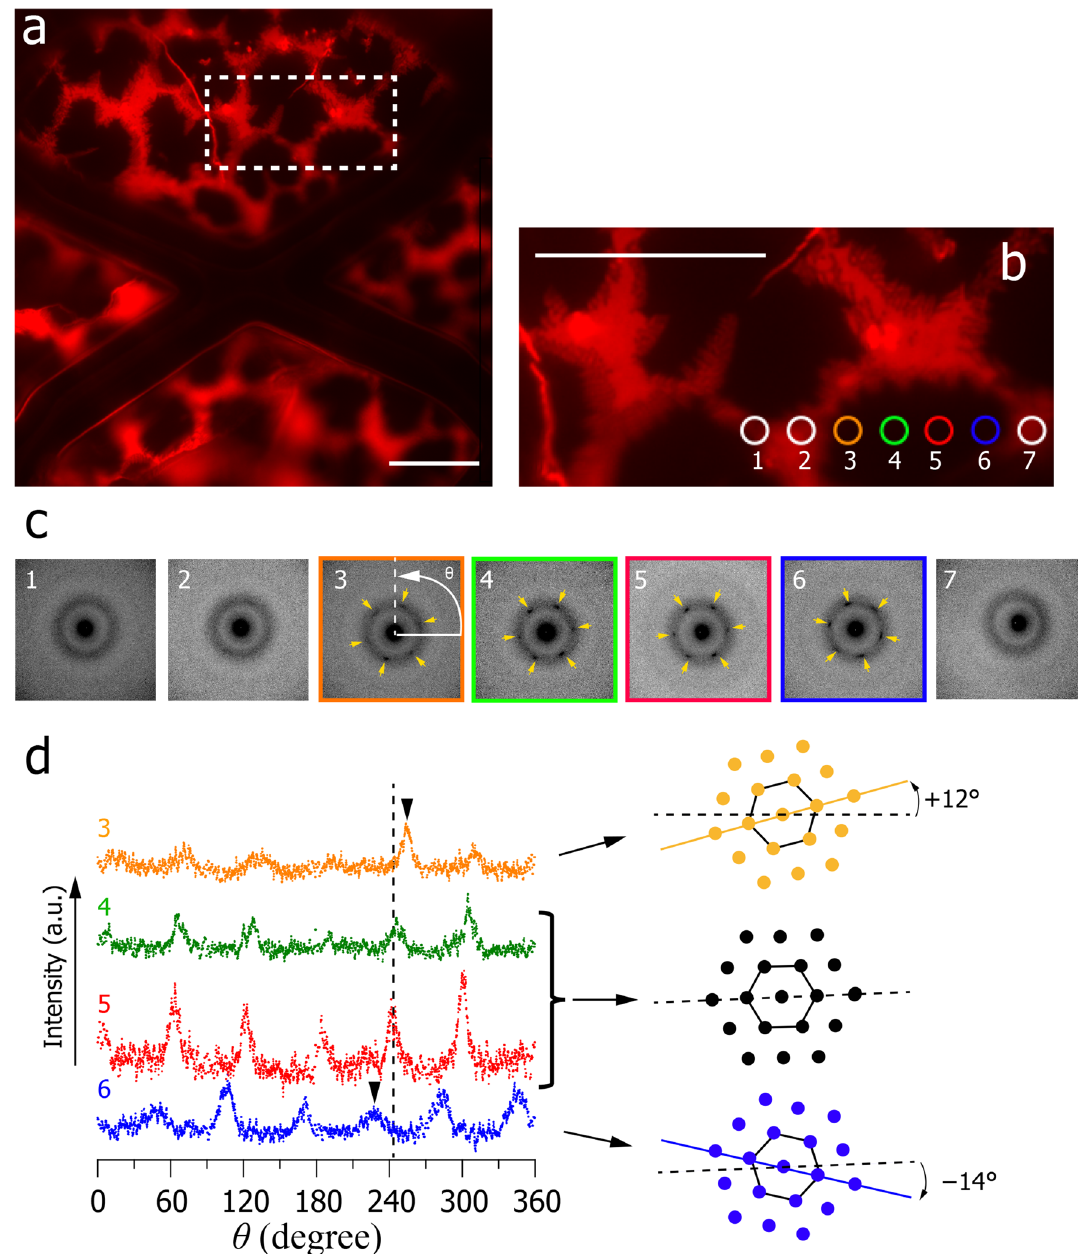
Figure 6. Local structure inside an ordered domain. ( a ) A fluorescent micrograph of the DSPC/DOPC ( x DSPC = 0.3) monolayer formed on a collodion-coated TEM grid. The darker and brighter regions correspond to the DSPC-rich ordered and DOPC-rich disordered domains, respectively. ( b ) Magnification of the area, which is indicated by the dashed square in ( a ). Bars indicate 30 μm. ( c ) The ED patterns obtained at regions 1–7, as indicated in ( b ). The selected area is 6.2 μm 2 , corresponding to 2.8 μm in diameter. The corresponding region numbers were directly indicated in the panels. ( d ) We plotted the intensity of the hexagonal spots appearing along the azimuthal direction θ , which is shown in panel ( c ). The corresponding region numbers are directly indicated in the panel. The difference in the azimuthal angle of the hexagonal spots between the centre (regions 4 and 5) and annular (regions 3 and 6) regions in the ordered domain are indicated by a dashed line and arrowheads, respectively. Schematic illustrations of the directions of the chain packing lattice in regions 3–6 are also shown in ( d